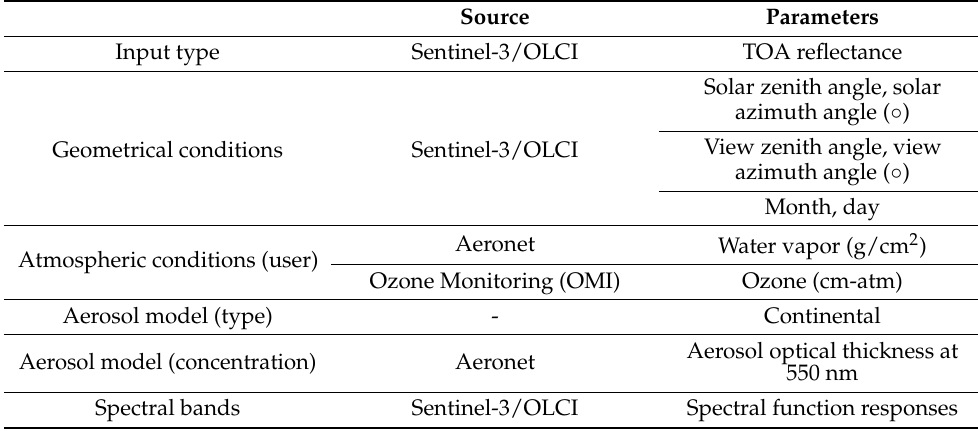
Table 2. Input parameters of 6SV model applied to